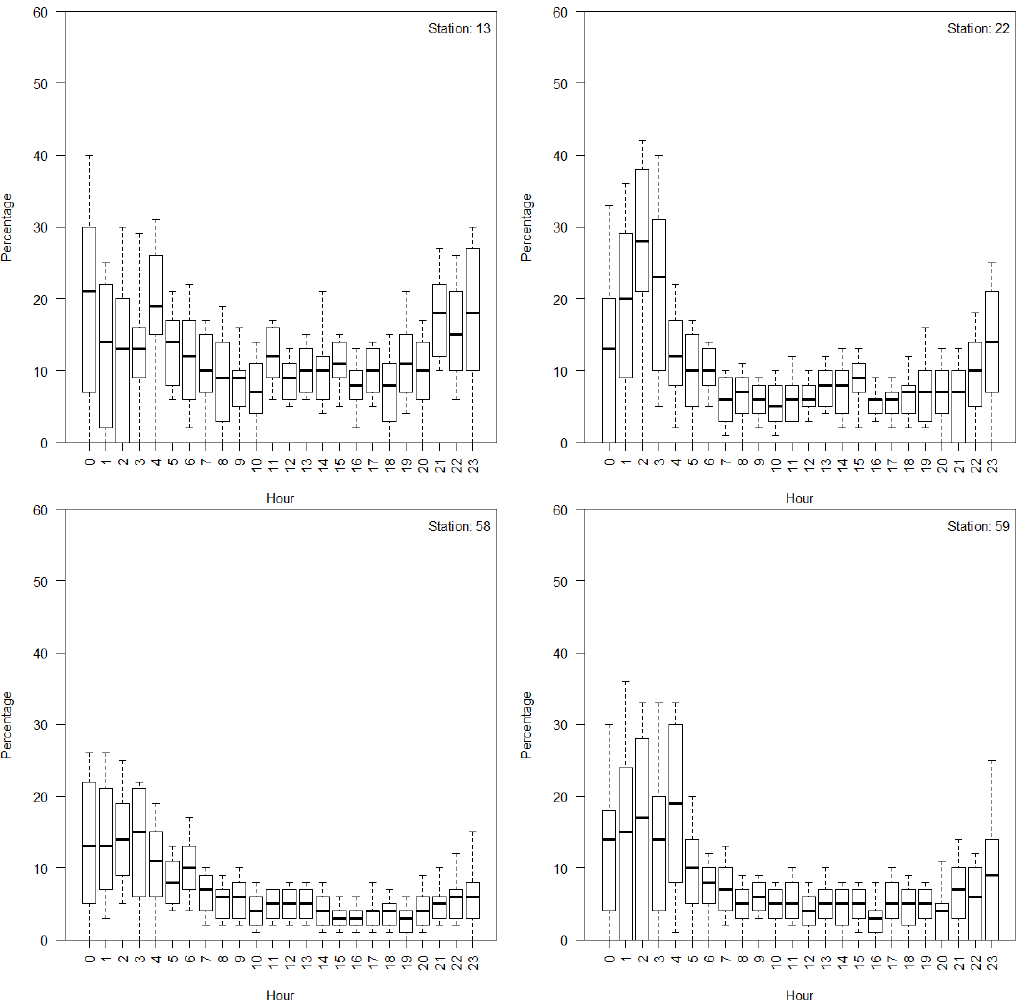
Figure 8: Percentage of category 11 vehicles with gross weight greater than 3750 kg in subsequent hours of the day of the measurement period for particular HS-WIM